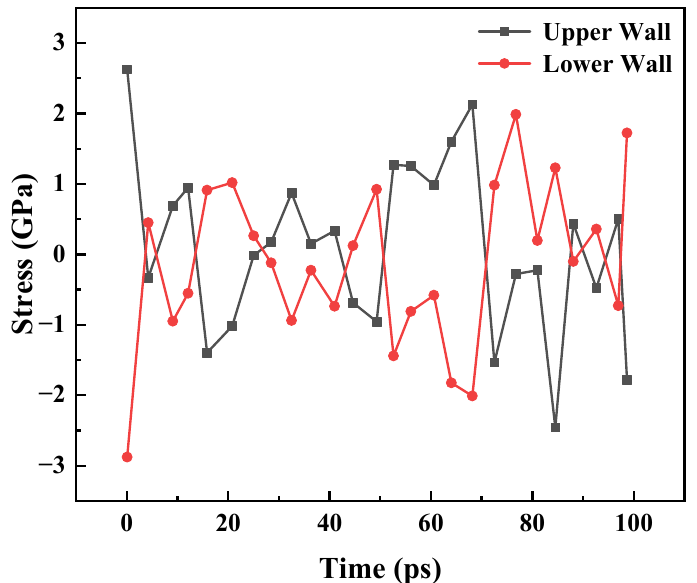
Figure 6. Changes of stress of warm mix asphalt lubricating film with simulation time at shear rate of 20 m/s.